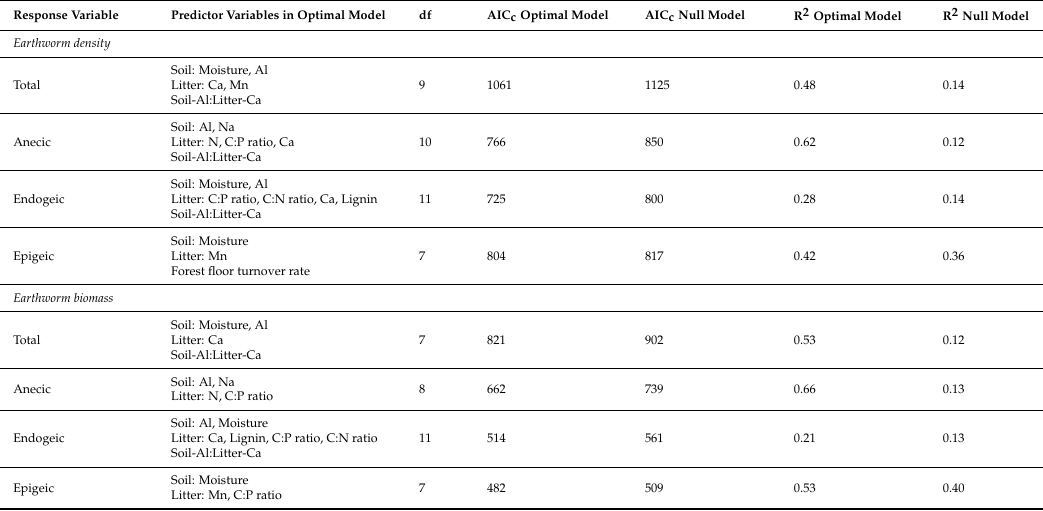
Table 4. Summary of the results identifying optimal models for total, anecic, endogeic and epigeic density and biomass. We used glmmADMB zero inflated models with Site as random effect, degrees of freedom (df), Akaike information criterion corrected for small sample sizes (AIC c ) and R 2 describing the correlation between fitted and observed values are shown. Soil predictor variables were measured in the topsoil (0–5 cm). Soil-Al:Litter-Ca is the interaction between exchangeable soil Al concentration and litter Ca concentration. The foliar litter nutrient concentrations were previously published by Vesterdal et al.